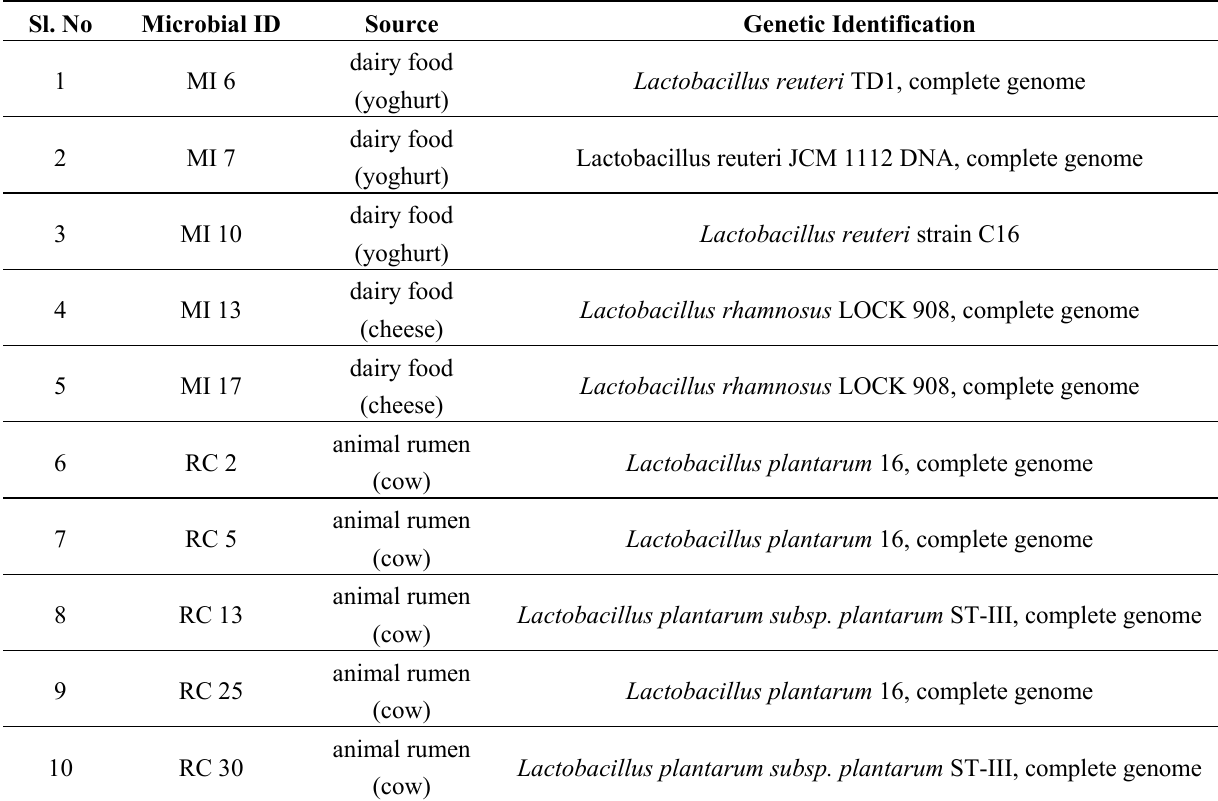
Table 2. Strain identification.